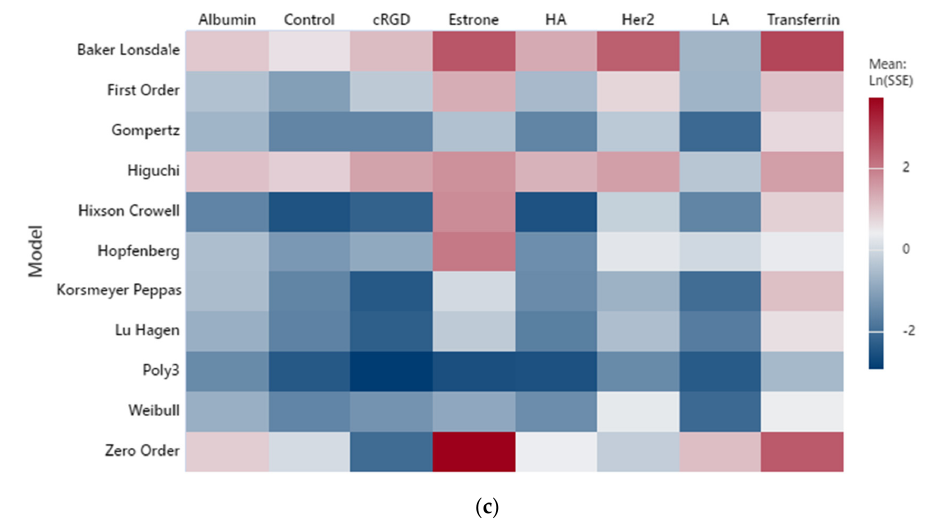
Figure 1. Heatmap for LFUS fittings at ( a ) 6.2 mW/cm 2 , ( b ) 9 mW/cm 2 and ( c ) 10 mW/cm 2 . The Korsmeyer–Peppas model also reflected a suitable fit for all the power densities, as shown in the heatmap. The estimated coefficients are reported in Table 4. Coefficients a and b correspond to k kp and n of the Korsmeyer–Peppas model, as shown in Table 3. The range for coefficient b (exponent of the model) spans between 0.62 and 0.99 (excluding estrone), thus implying a non-Fickian transport. Anomalous transport is a type of non- Fickian transport with 0.43 < b < 0.85 for a spherical geometry (such as liposomes) [35]. Most of our moieties follow anomalous transport, with very few expressing super case II transport (b > 0.85). Anomalous transport is characterized by solvent diffusion and relax- ation of polymeric chains occurring with comparable magnitudes [35]. Thus, drug release is driven by diffusion and swelling. When the velocity of solvent diffusion is higher than polymeric relaxation, the mechanism of drug release is characterized by super case II transport. Table 4. Korsmeyer–Peppas model coefficients a and b at 20 kHz.